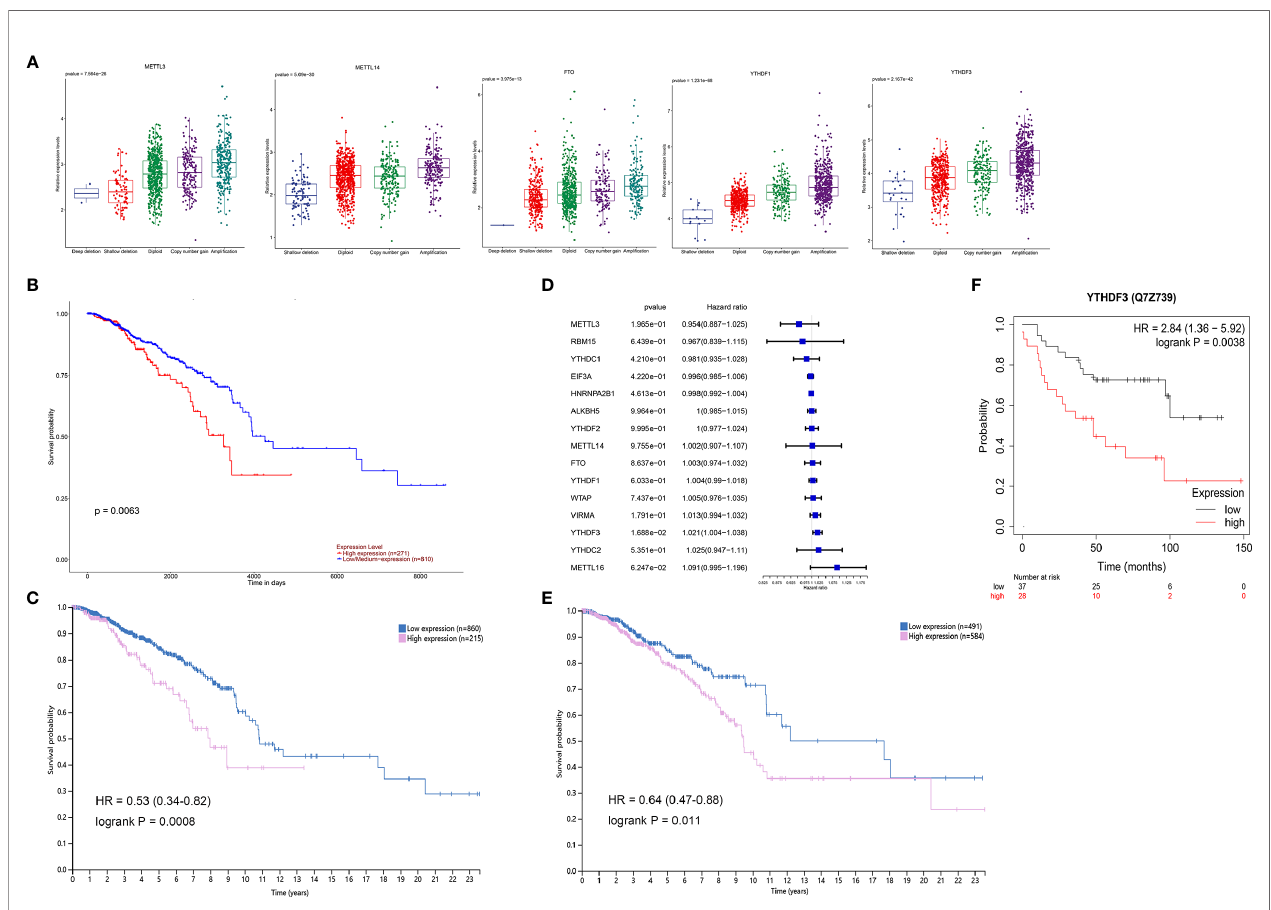
FIGURE 3 | The survival correlation of YTHDF1 and YTHDF3 in breast cancer based on the online database. (A) The correlations between different CNV patterns and mRNA expression levels of fi ve m 6 A regulators; other regulators were represented in Supplementary Figure S2 . (B) Overall survival analysis for high and low/ medium expression of YTHDF1 using Kaplan-Meier curves by UALCAN analysis, p = 0.0063. (C) The correlation of YTHDF1 expression and patients ’ survival in breast cancer based on the HPA, p = 0.0008. (D) The prognostic analyses for 15 m 6 A regulators in breast cancer based on TCGA database using a univariate Cox regression model. Hazard ratio >1 represented risk factors for survival. (E) The correlation of YTHDF3 expression and patients ’ survival in breast cancer based on the HPA, p = 0.011. (F) The correlation of YTHDF3 protein expression and patients ’ survival in breast cancer by Kaplan-Meier Plotter tool, p =